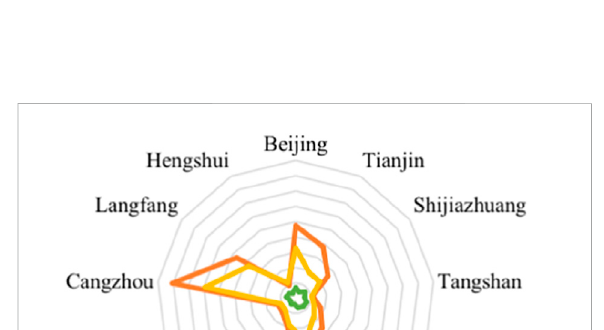
FIGURE 1 Degree of Compactness of production-living-ecological space in Beijing-Tianjin-Hebei.